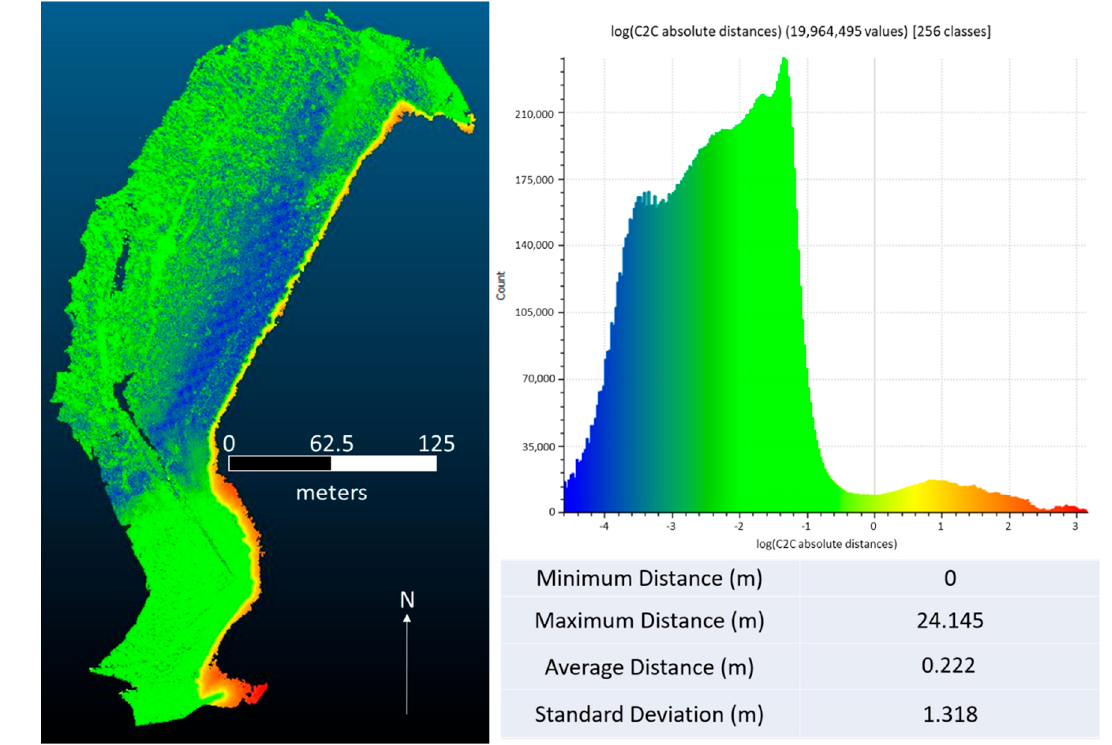
Figure 9. A model of Newcastle Dam showing the difference in point clouds due to masking and omitting water from sparse cloud alignment. A log transform was performed on the initial error measured in meters because the distribution of error was extremely right-skewed. Errors under 1 cm were omitted from the dataset so the log transform of the error could be taken. These are Euclidian distances measured in three dimensions, not just the horizontal